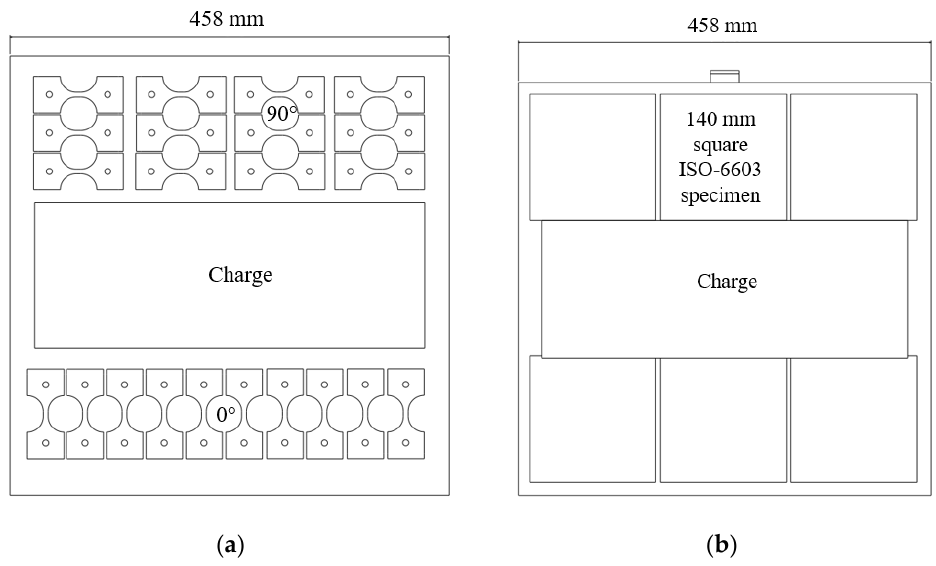
Figure 5. ( a ) Intermediate strain rate specimen layout, ( b ) ISO6603 specimen layout.